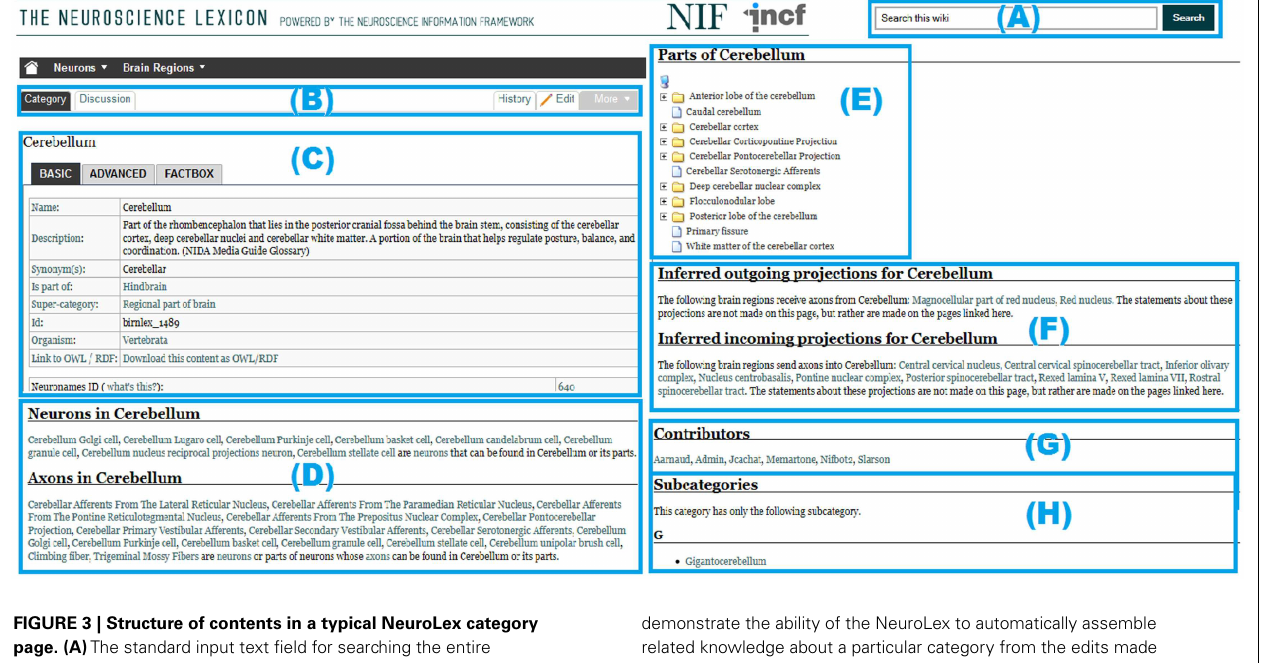
demonstrate the ability of the NeuroLex to automatically assemble related knowledge about a particular category from the edits made in other NeuroLex pages. (G) The list of contributors who made edits to the page. (H) The list of subcategories of a particular category